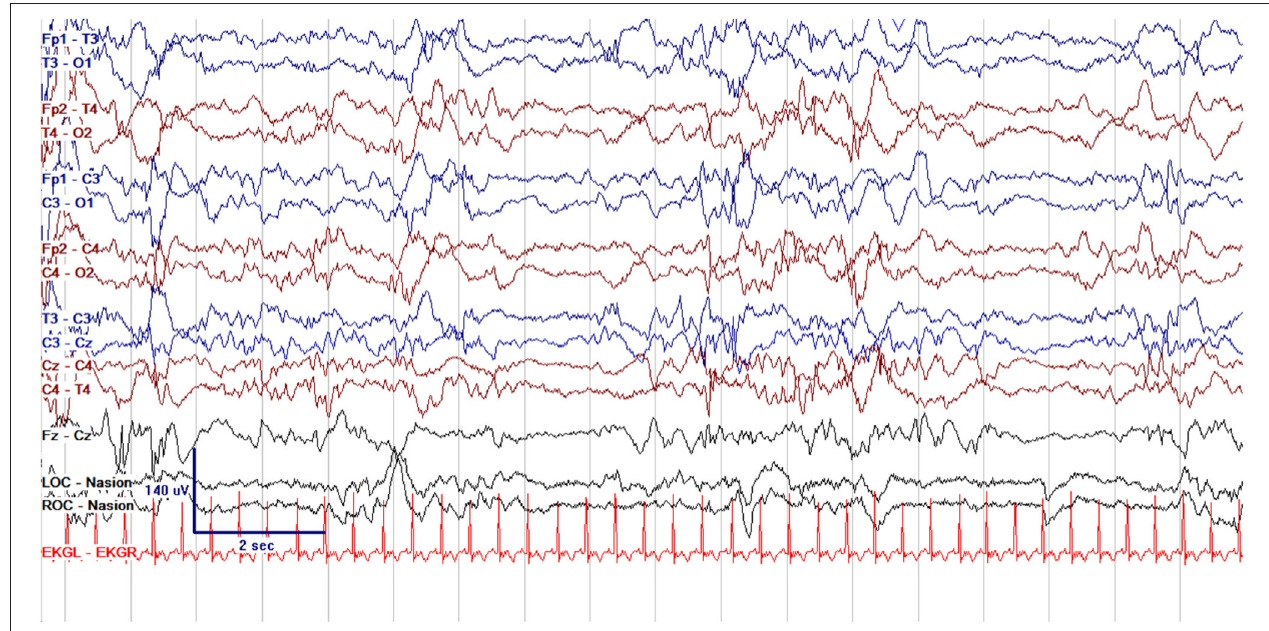
FIGURE 3 | Normal cEEG in the same term neonate in quiet sleep, with normal discontinuity (trace alternans) with interburst intervals lasting up to 6s and of voltage > 25 µ V.